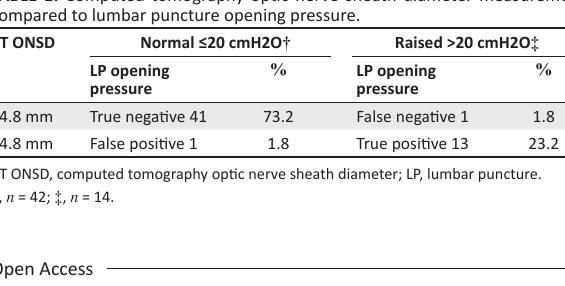
TABLE 1: Computed tomography optic nerve sheath diameter measurements compared to lumbar puncture opening